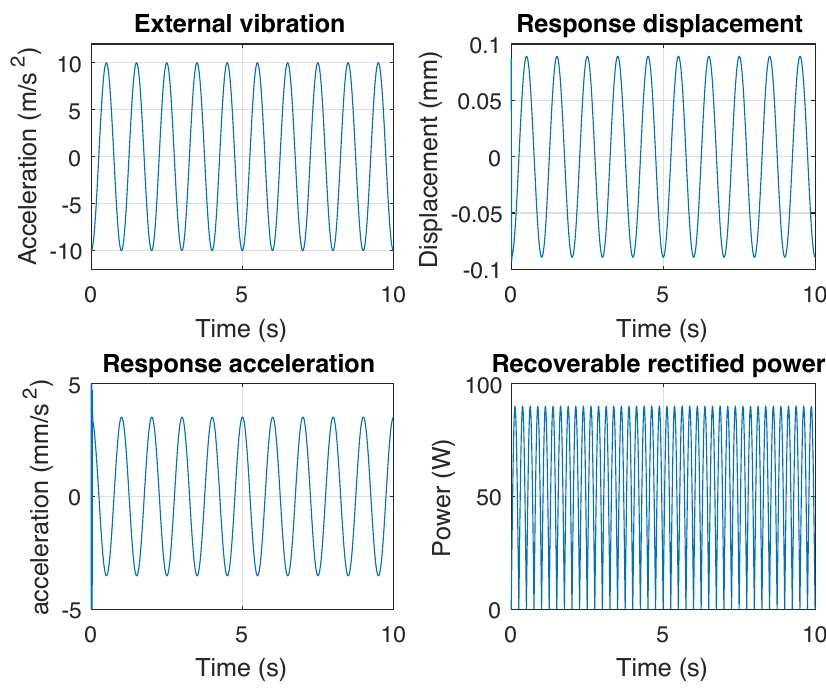
Figure 6. Time domain response of the magnetic suspension and the unsprung mass when subjected to a sinusoidal excitation of 10 m/s 2 at 10